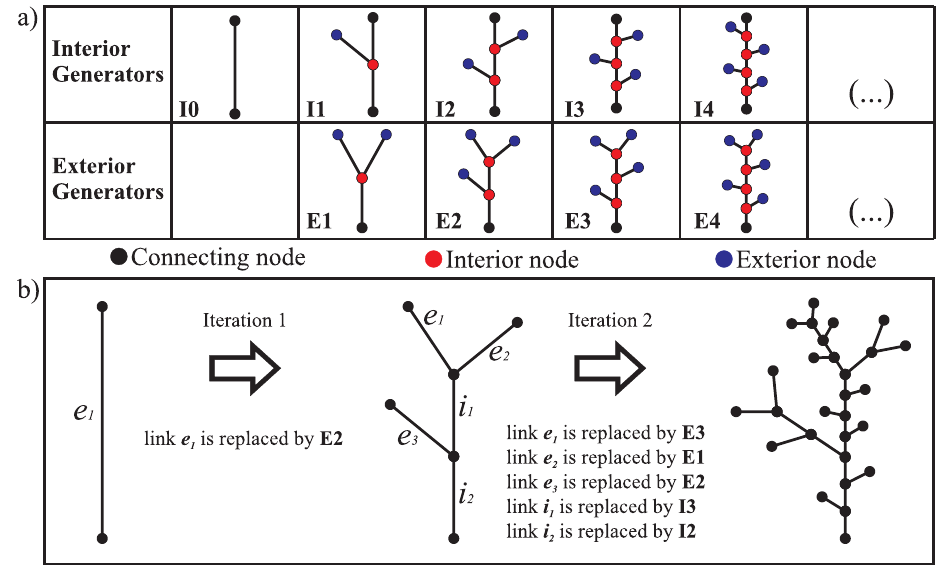
Fig. 1. (a) The populations of interior and exterior path-based generators. Generators are labeled by bold letters I (interior) and E (exterior) followed by an integer that represents number of interior nodes in the generator. (b) Two steps in the construction of an RSN indicating the replacements made.